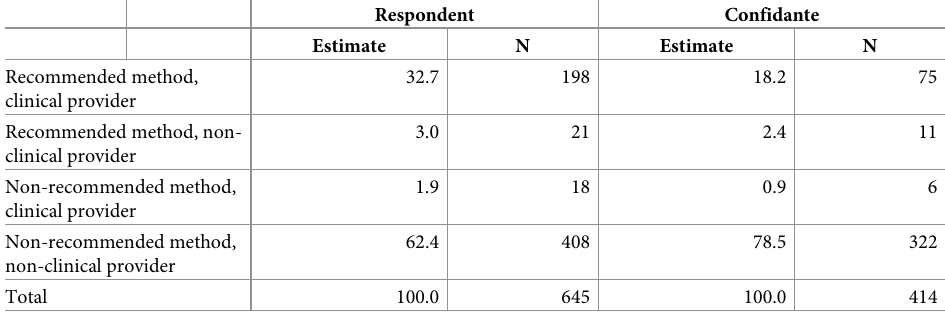
Table 3. Safety of most recent reported likely-abortion among female respondents age 15 to 49 and their closest female confidantes age 15 to 49 in Coˆte